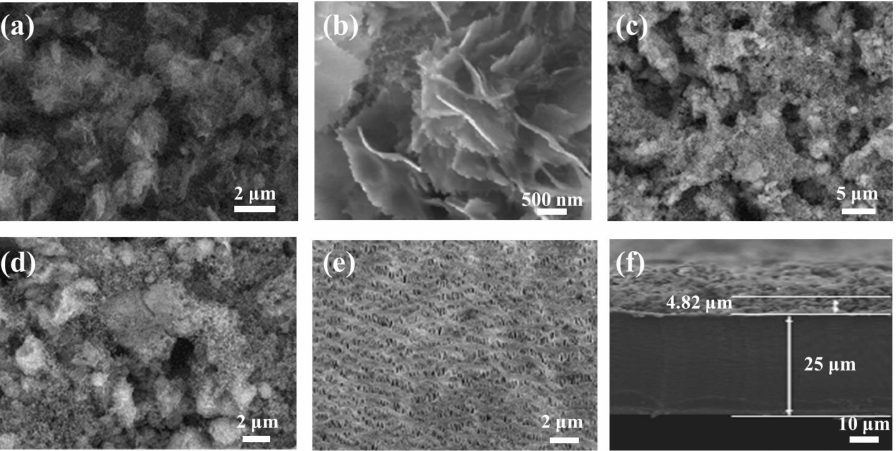
Figure 2. ( a , b ) SEM images of ATG-DMTZ-COF. ( c , d ) Morphology of ATG-DMTZ-COF/PP separator. ( e ) Morphology of blank PP separator. ( f ) The SEM of ATG-DMTZ-COF/PP separator cross